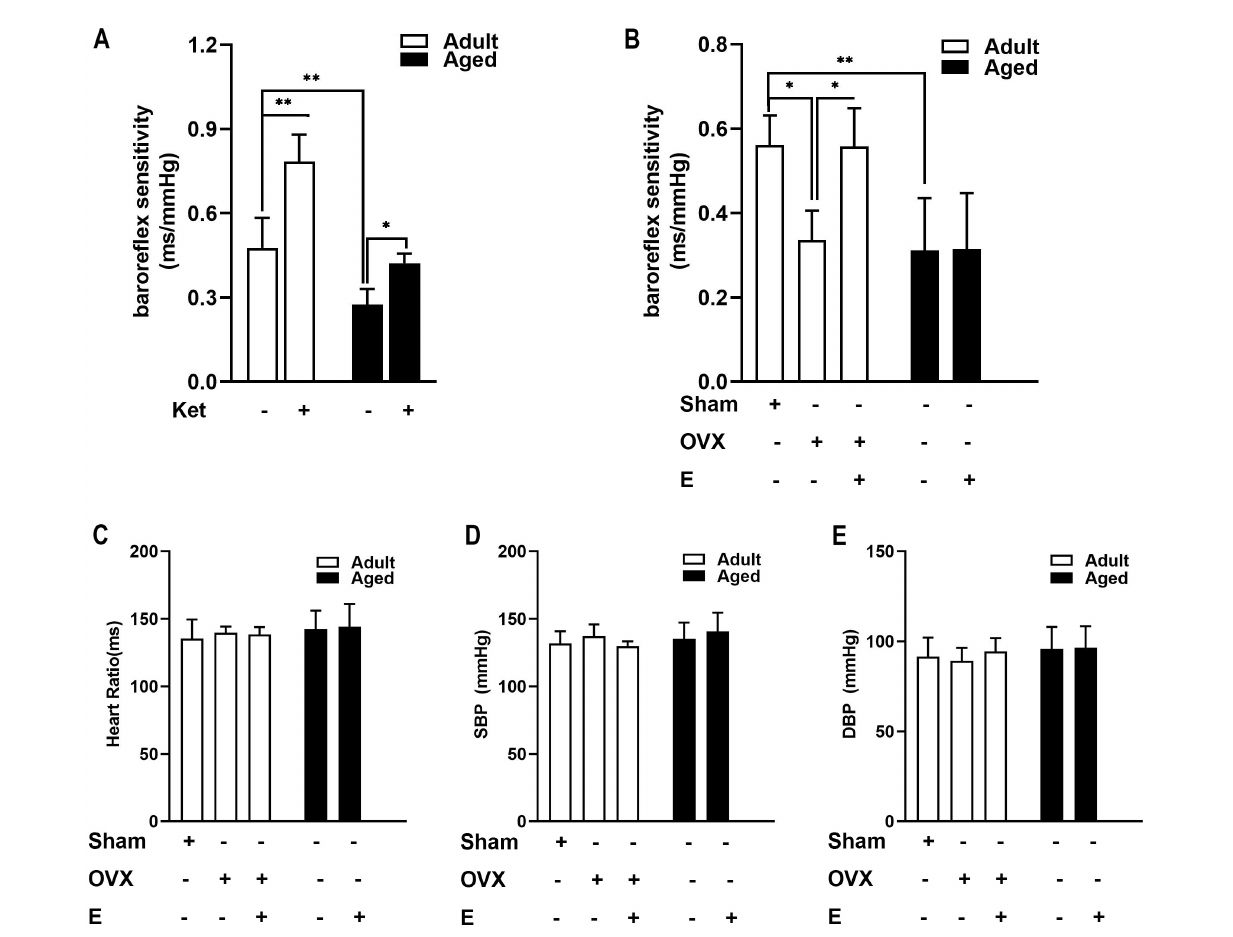
FIGURE 2 Estrogen supplements improved arterial baroreflex (ABR) function in adult OVX rats but not in aged rats. (A) Ketansarin (Ket) (0.3 mg/kg/d), as a positive control group, significantly increased BRS in both adult and aged rats. (B) In adult rats, OVX led to a baroreflex dysfunction and exhibited a reduced BRS value, whereas estrogen replacement restored BRS values. The function of arterial baroreflex was weaker in aged rats than in adult rats, and estrogen supplements failed to improve BRS. (C–E) Estrogen pretreatment did not change systolic blood pressure (SBP), diastolic blood pressure (DBP) and heart period in adult and aged rats. Data were analyzed by the one-way analysis of variance (ANOVA) followed by least significant difference t -test, n = 5–6 in each group. * p < 0.05, ** p < 0.01.